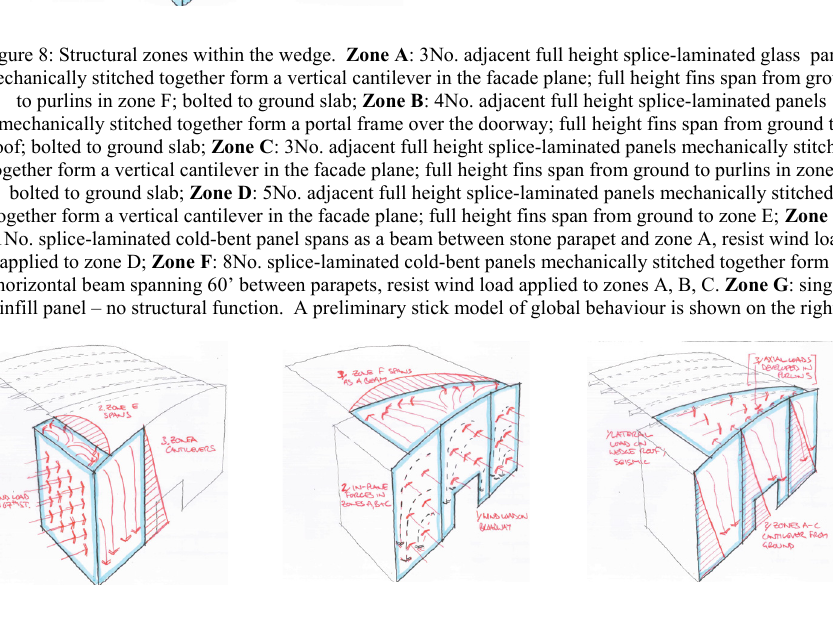
Figure 10: SS2, Wind load on Broadway façade. Note developed in-plane forces, see 3.2